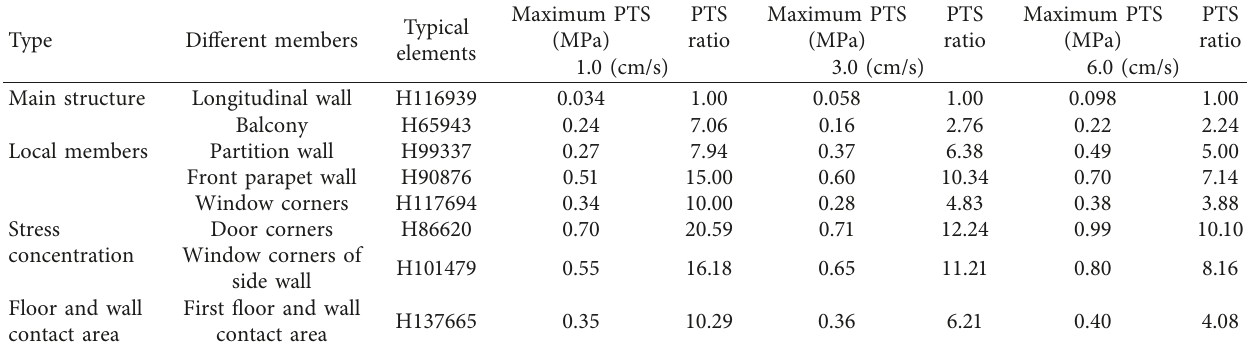
Table 8: PTS and PTS ratio of local members under different peak particle velocities.